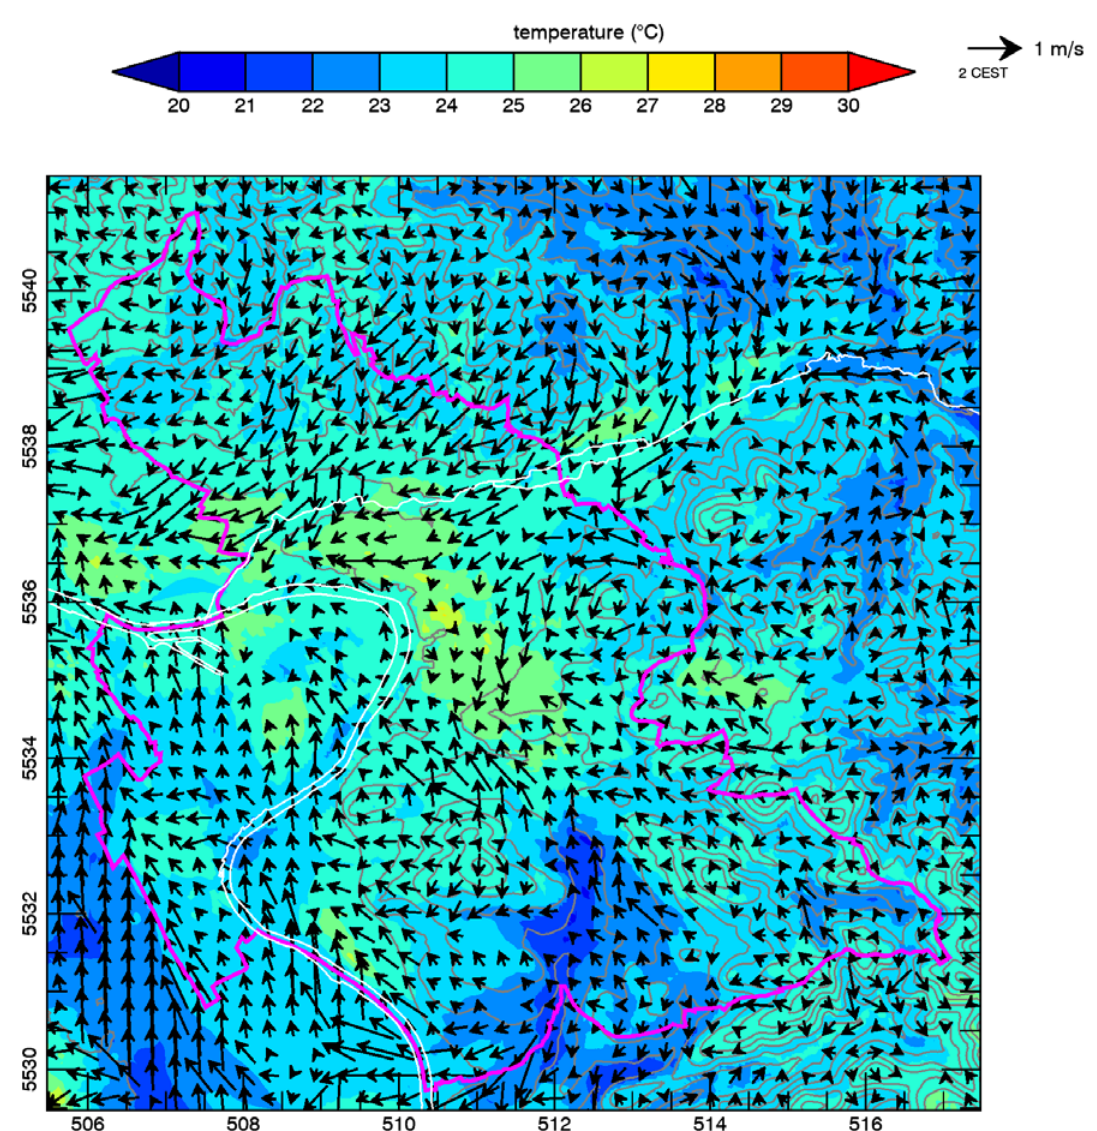
Figure 5. 02:00 CEST map of the air temperature (°C) and wind vectors (m/s) within the 12 km × 12 km city subdomain at 5 m above ground level. Terrain elevation contour lines are shown in grey, rivers in white, and the city border of Aschaffenburg in magenta.